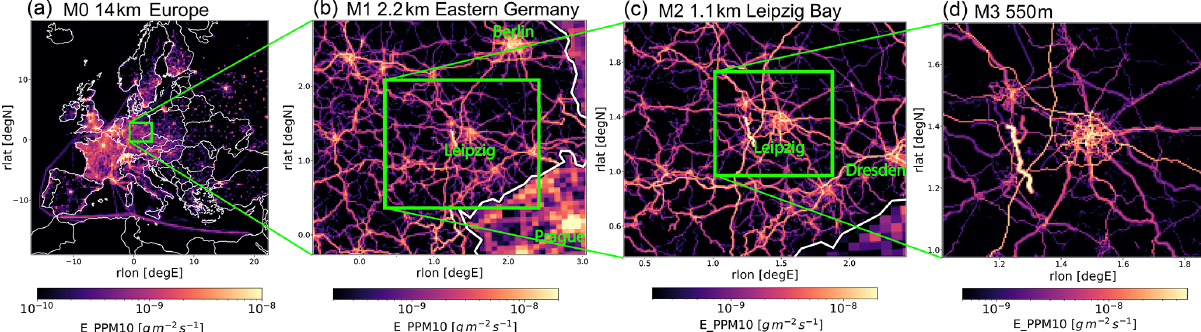
Figure 5. Nested domains of the precursor simulations using COSMO-MUSCAT: (a) M0, 14km; (b) M1, 2.2km; (c) M0, 1.1km; and (d) M3, 550m. Displayed are the primary PM 10 emissions of the transport sector (SNAP categories 7 and 8). Note that the displayed range differs between the plots to account for the increased resolution of road emissions from (a) to (d) . The maps are in rotated geographic coordinates, where the coordinates of the rotated pole are 40 ◦ N, − 170 ◦ E.